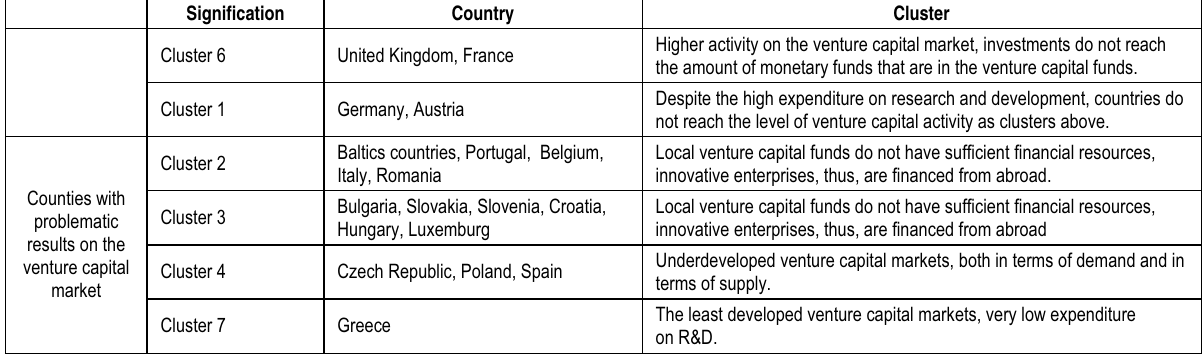
Table 1 (cont.). Typology of EU countries according to the situation on the venture capital market